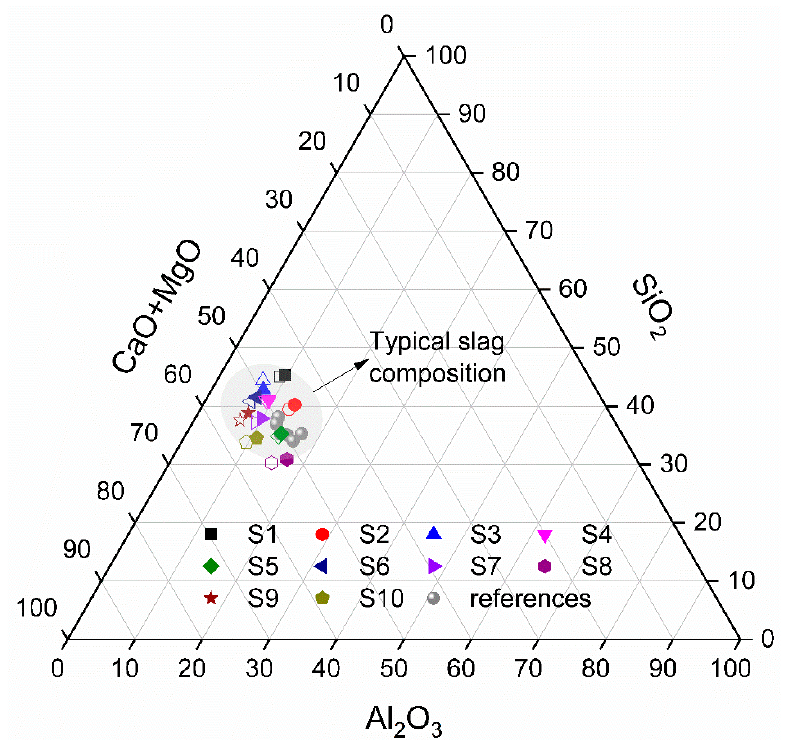
Figure 3. Chemical compositions of air quenched slags in the (CaO + MgO)-SiO 2 -Al 2 O 3 ternary system (in wt.%). The solid points are taken from XRF results of synthetic slags. The hollow points which have the same shape with the solid points are the designed compositions of slags in Table 2. The points marked as references are the XRF compositions of several water quenched slags from references [2,3,5].